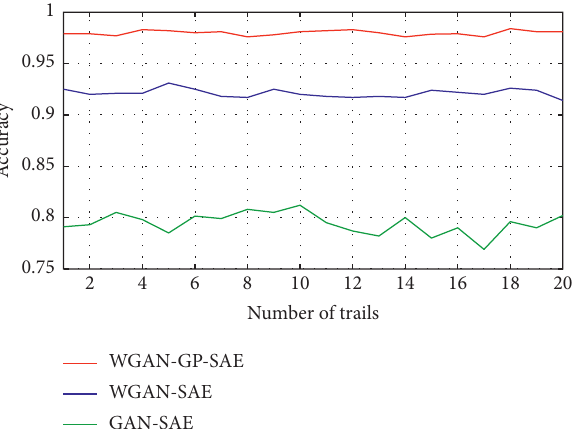
Figure 11: Testing accuracies of the three datasets using the three methods on the dataset of